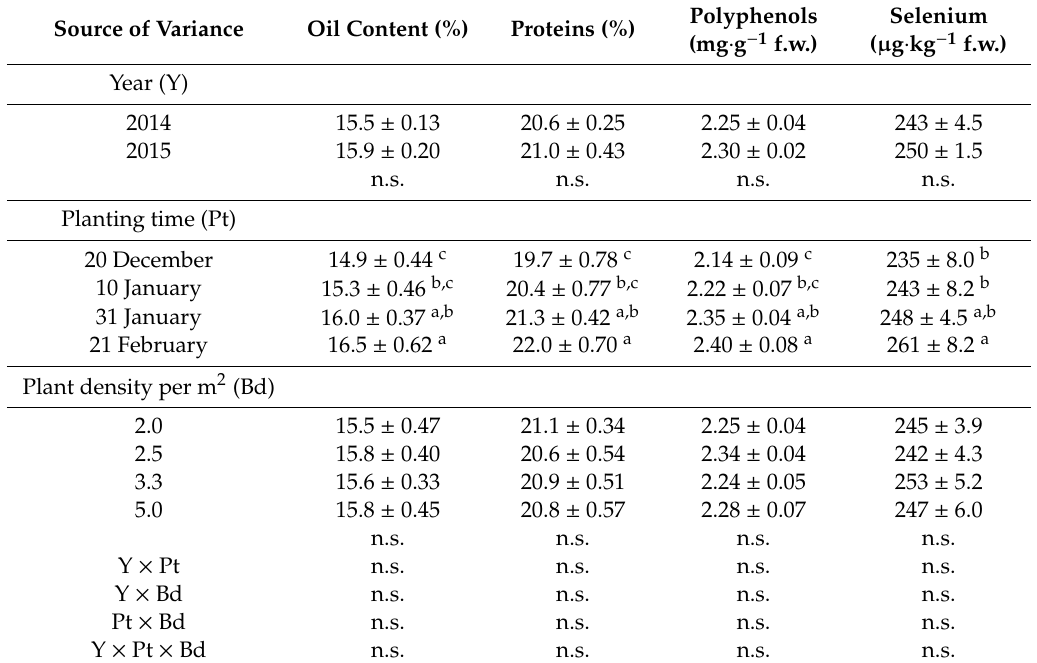
Table 5. Mean values of oil, protein, and antioxidants content of onion seeds as a ff ected by bulb planting time and density ( n = 3 ±